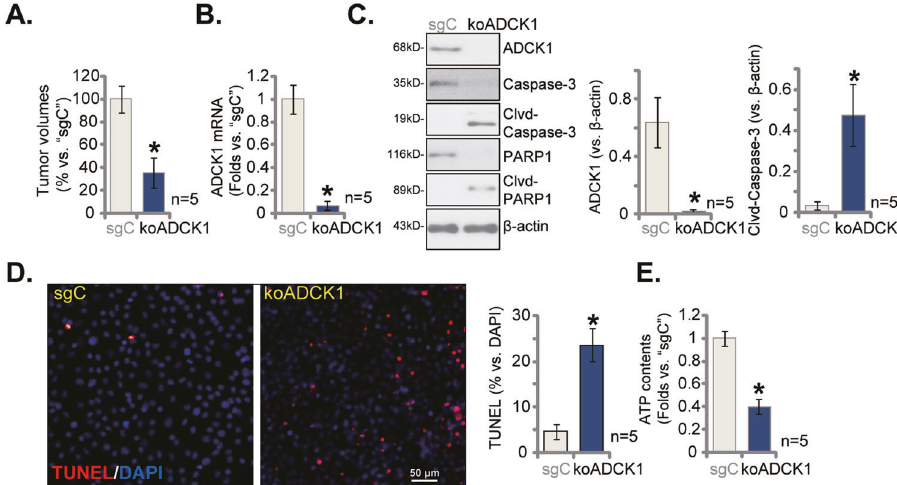
Fig. 9 ADCK1 KO inhibits pOS-1 xenograft in situ growth. The sg-C expressing pOS-1 cells or the koADCK1 pOS-1 cells were injected to proximal tibia of the nude mice; After 30 days, in situ pOS-1 tumors were detected by X-ray, with its volumes recorded ( A ); Expression of listed genes in tumor lysates was shown ( B , C ), and ATP contents examined as well ( E ). The representative TUNEL-DAPI immuno- fl uorescence images of the xenograft slides were presented ( D ), with TUNEL-positive nuclei ratio quanti fi ed ( D ). Data were presented as mean ± standard deviation (SD). * P < 0.05 vs. “ sgC ” group. Scale bar = 50 μ m ( D